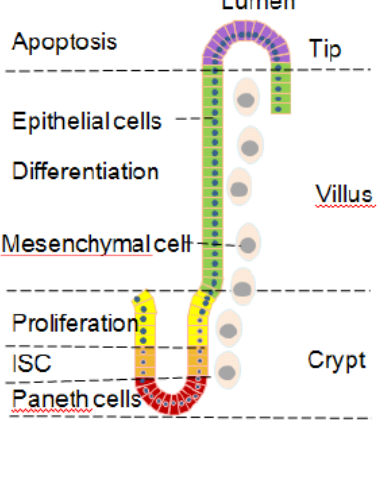
Figure 1. Schematic diagram of the cell population in the mouse small intestinal epithelium. Please note that the intestinal stem cells (ISCs), proliferating progenitor cells, and differentiated cells are located in spatially defined compartments in the intestinal crypt and